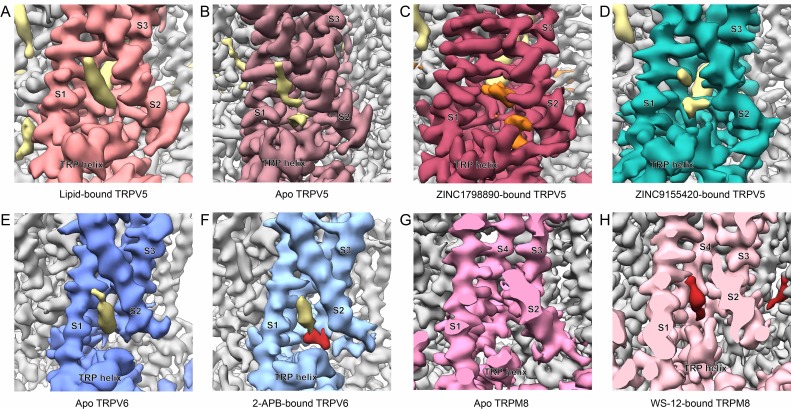
Ligand binding in the intracellular S1-S4 bundle.Cryo-EM density maps of the intracellular S1-S4 bundle of (A) lipid-bound TRPV5 (EMB-7965) with the lipid shown in khaki, (B) apo TRPV5 (EMB-0594) with lipids shown in khaki, (C) ZINC17988990-bound TRPV5 with ZINC17988990 shown in orange, (D) ZINC9155420-bound TRPV5 with non-protein density shown in khaki (E) apo TRPV6 (EMB-7824) with the lipid shown in khaki, (F) 2-APB-bound TRPV6 (EMB-7825) with the lipid shown in khaki and 2-APB shown in red, (G) apo TRPM8 (EMB-7127) and (H) WS-12-bound TRPM8 (EMB-0487) with WS-12 shown in red.